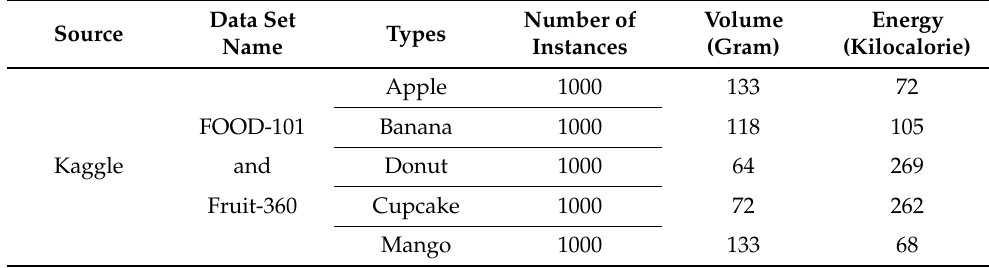
Table 2. Data selection from two different data set with a typical nutrition table